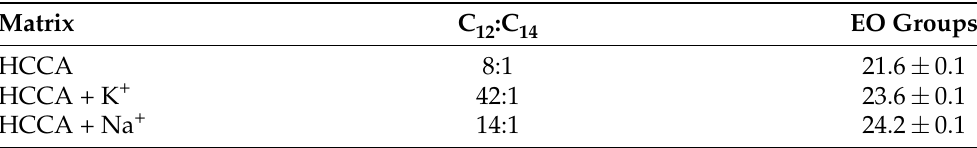
Figure A3. MALDI-TOF spectra of BrijL23 from a pure HCCA matrix and from HCCA matrices upon addition of K + or Na + salt. Table A2. Key findings from mass spectrometry measurements of BrijL23: the ratio between C 12 and C 14 alkyl chains of the hydrophobic tail and the total number of EO groups per molecule.